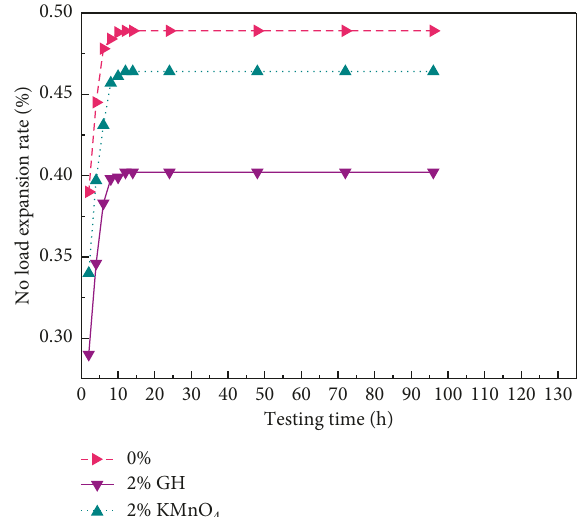
Figure 5: The expansion rate of dredged sludge solidified soil at different test times. Table 7: Leaching tests results of solidified dredged sludge samples.